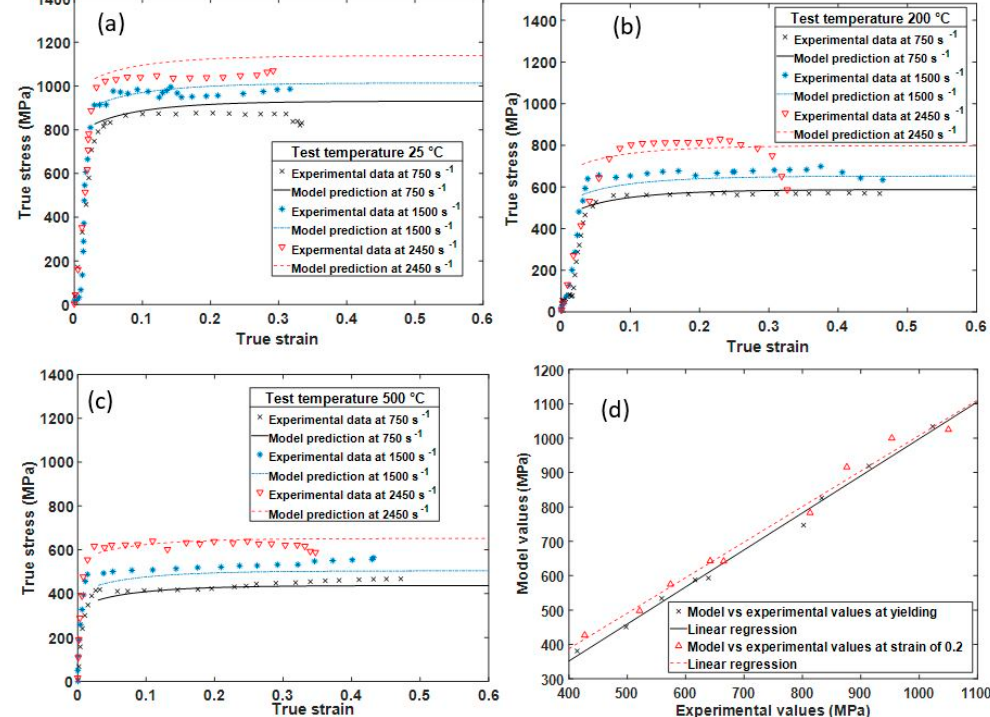
Figure 12. Comparison of the modified model prediction and experimental results for sample D at three high strain rates and at test temperatures of ( a ) 25 °C, ( b ) 200 °C, and ( c ) 500 °C, and ( d ) the correlation between the predicted values and those obtained from experimentation at yielding and at a strain of 0.2.